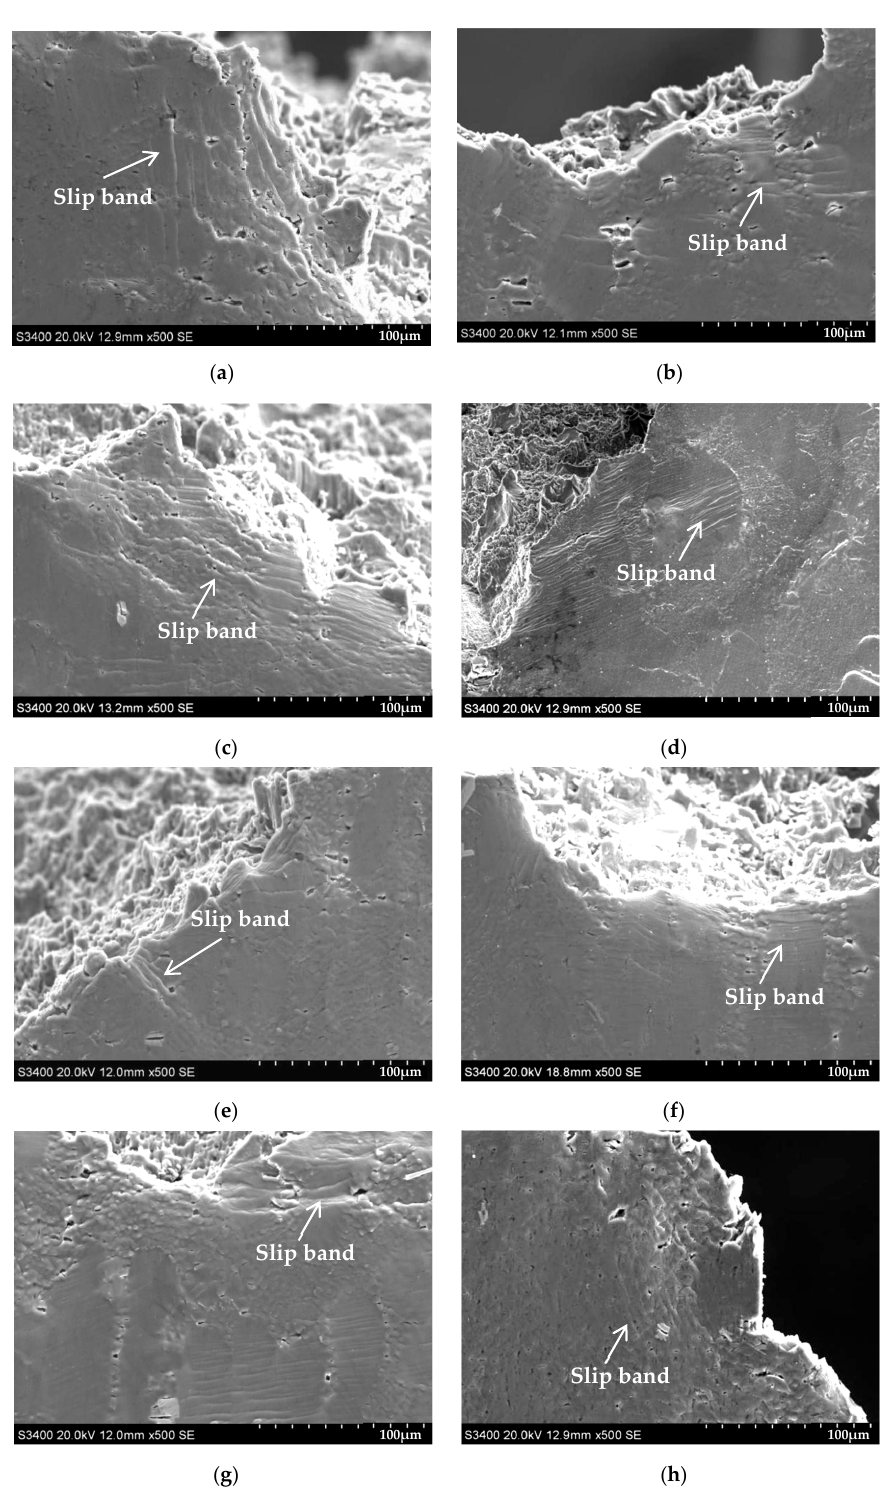
Figure 8. Effect of alloying elements on the slip bands near the tensile fracture of Al-Si alloys at room (20 °C) and low ( − 60 °C) temperature: ( a ) Al-10Si-0.3Mg, 20 °C; ( b ) Al-10Si-0.3Mg, − 60 °C; ( c ) Al-10Si-0.3Mg-0.2Er, 20 °C; ( d ) Al-10Si-0.3Mg-0.2Er, − 60 °C; ( e ) Al-10Si-3Cu-0.3Mg, 20 °C; ( f ) Al-10Si-3Cu-0.3Mg, − 60 °C; ( g ) Al-10Si-3Cu-0.3Mg-0.2Er, 20 °C; ( h ) Al-10Si-3Cu-0.3Mg-0.2Er, − 60 °C.